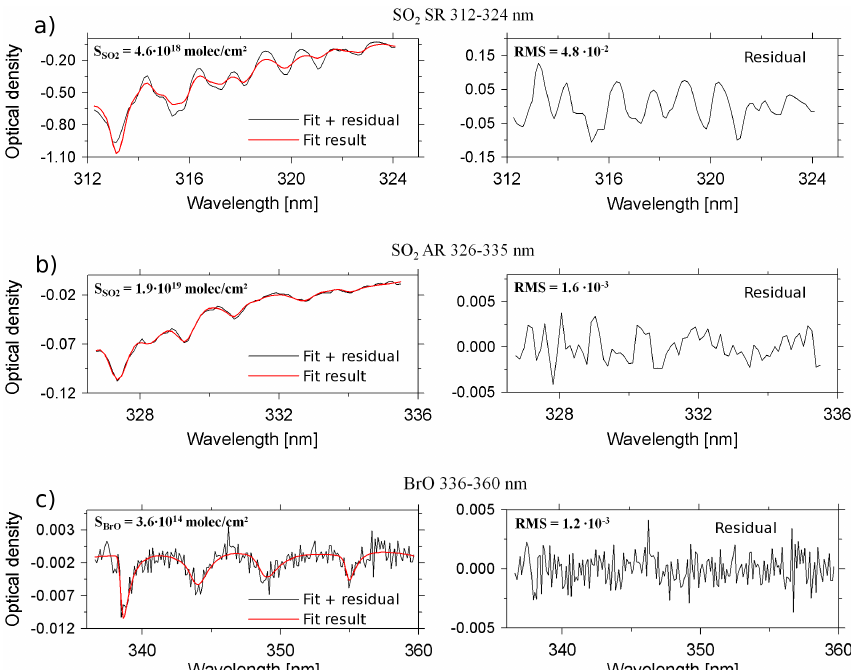
Fig. 1. Example of all three fit-scenarios, (a) SO 2 standard retrieval 312.1–324nm, (b) SO 2 alternative retrieval 326.5–335.3nm, (c) BrO retrieval 336–360nm, for a GOME-2 pixel in the volcanic plume of Kasatochi on 9 August 2008 (21:05UTC, centre coordinates 160.01 ◦ W 46.87 ◦ N). Left column: Fit results including the residual (black lines) and reference spectra (red lines) scaled according to the fit results (the resulting SCD (S) and root-mean-square (RMS) is also noted). Right column: corresponding residuals (please note expanded